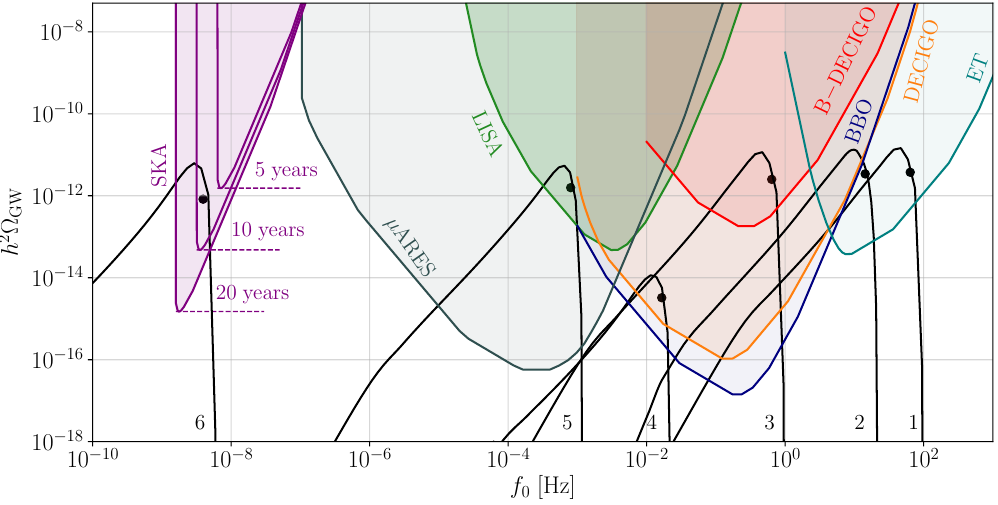
Figure 5: Present-time GW spectra (black lines) for the benchmark parameter points listed in Table 1 along with the corresponding estimates of the peak position (black dots). A good agreement between the estimates and the peak positions of the cor- responding spectra obtained from simulation can be seen. The colored regions indi- cate the power-law integrated sensitivity of various future GW observatories. Spec- tra reaching into the colored regions can be detected in the respective observatory, demonstrating that, in the model considered here, observable signals can be obtained over a large range of